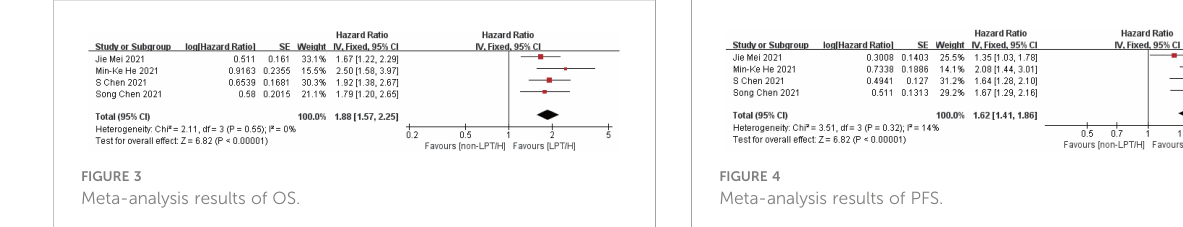
FIGURE 4 Meta-analysis results of